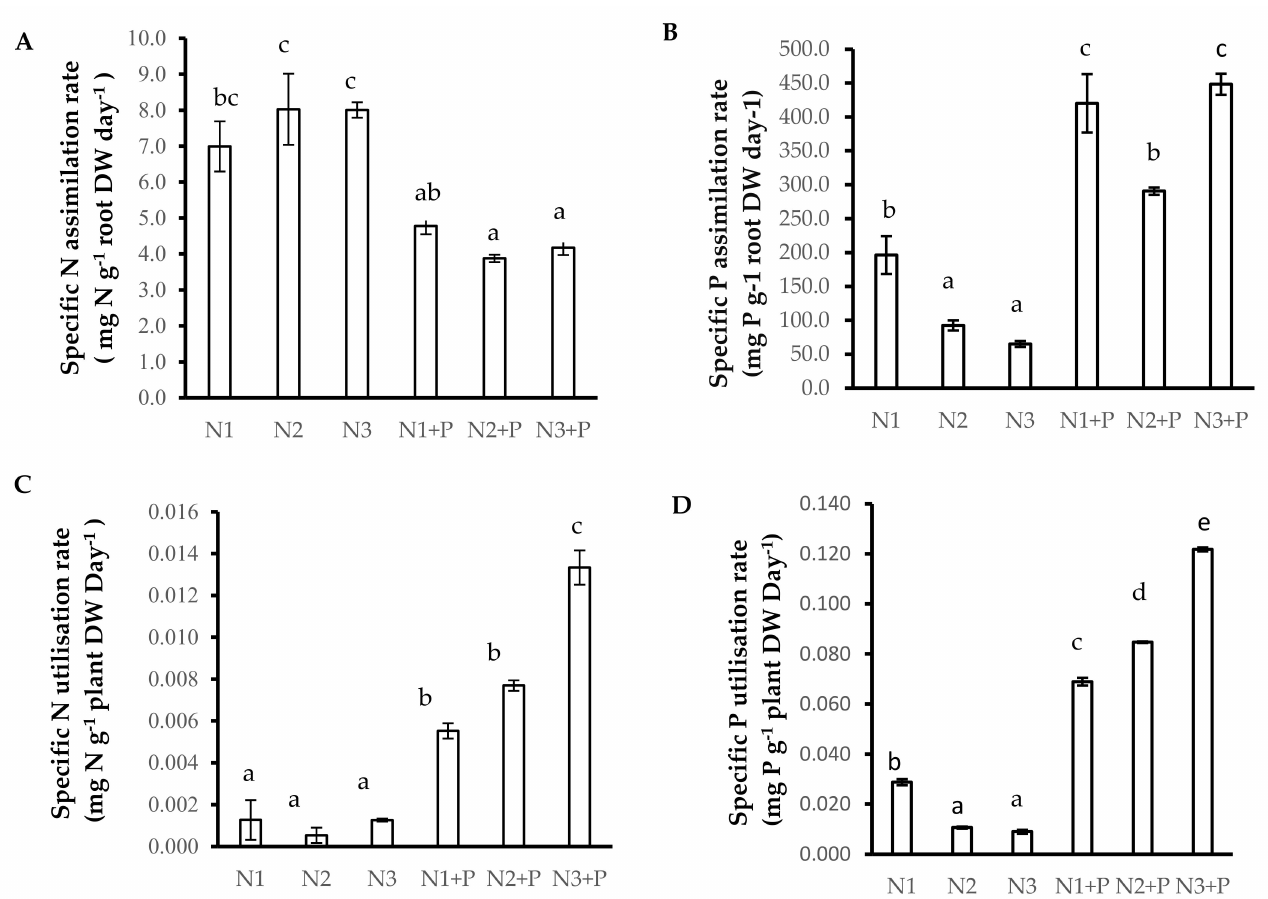
Figure 2. N and P use efficiency (( A ). Specific N assimilation rate, ( B ). Specific P assimilation rate, ( C ). Specific N utilisation rate, ( D ). Specific P utilisation rate) of 180-day-old V. nilotica saplings grown in Ukulinga Farm soils. Values represent the mean ± SE, based on n = 5. Significant differences ( p < 0.05) among treatments are denoted by different superscript